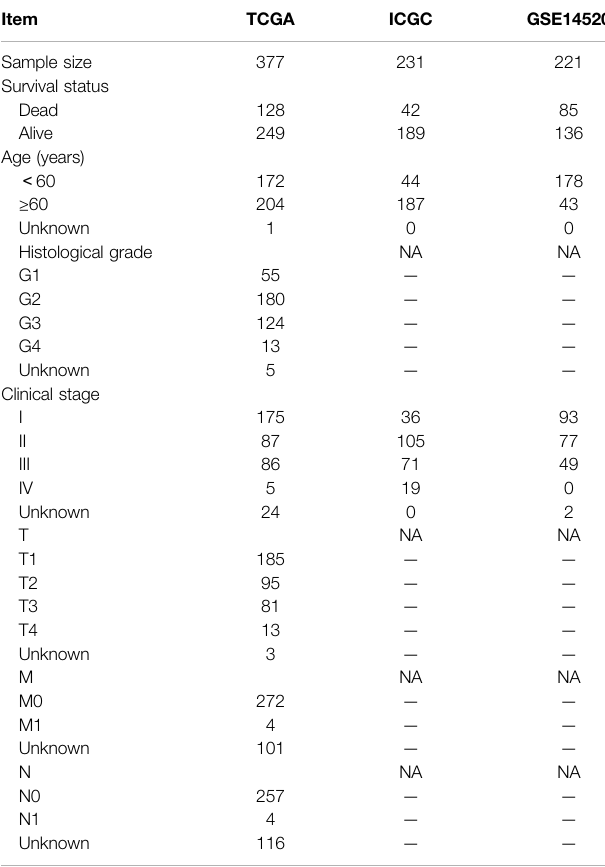
TABLE 1 | Clinical characteristics of TCGA, ICGC, and GSE14520